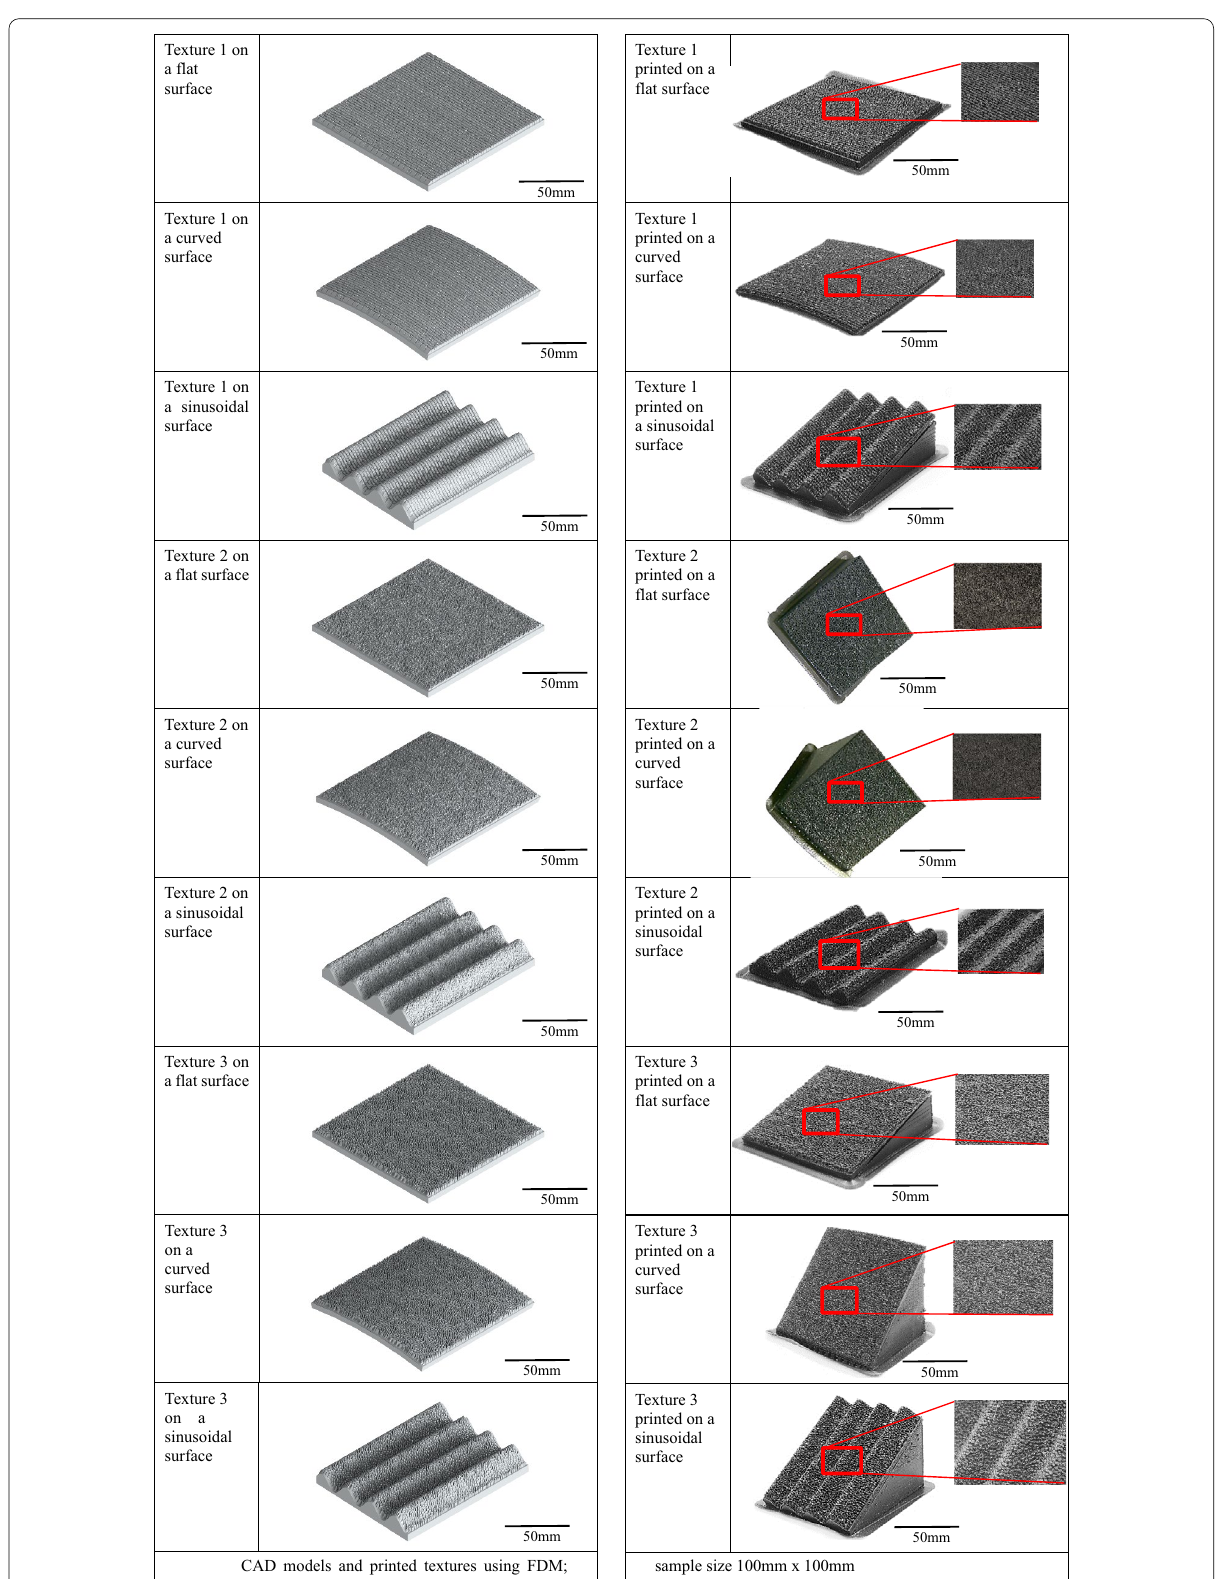
Figure 13 CAD models and printed textures using FDM; sample size 100 mm